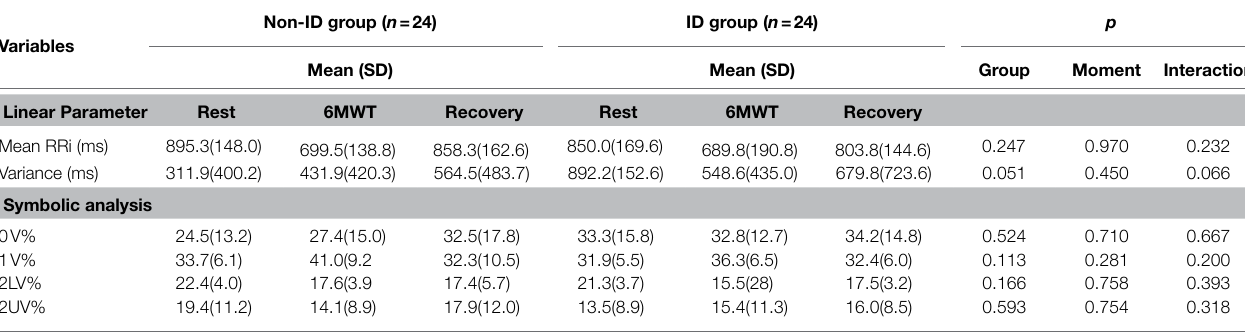
TABLE 2 | Mean, variance, and symbolic analysis in older adults with and without ID.